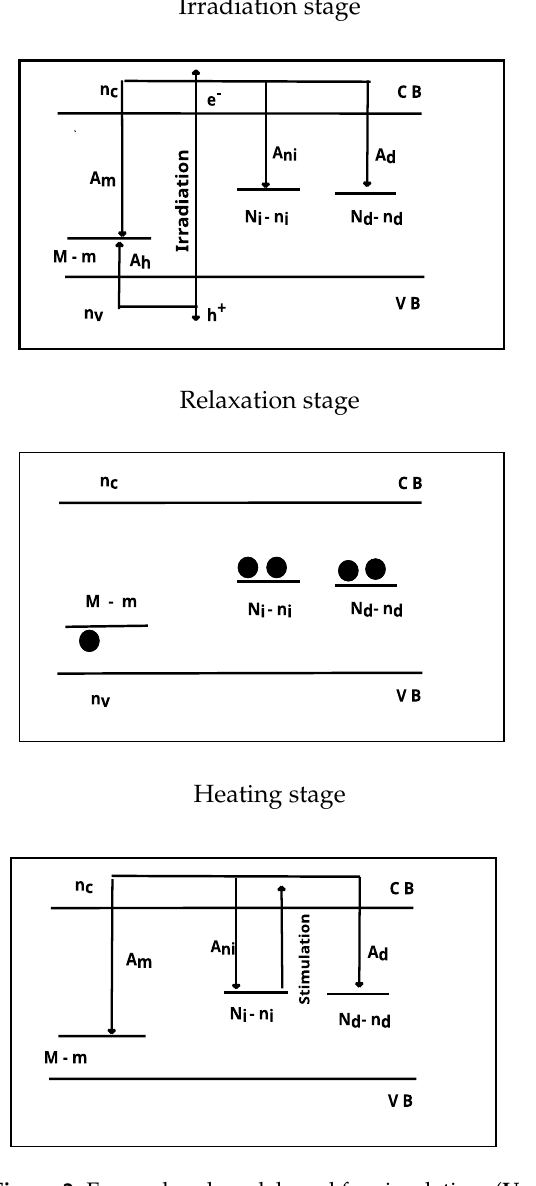
Figure 2. The energy band model used for simulation. ( Upper ): Irradiation stage. ( Middle ): Relax- ation stage. ( Down ): Heating stage.